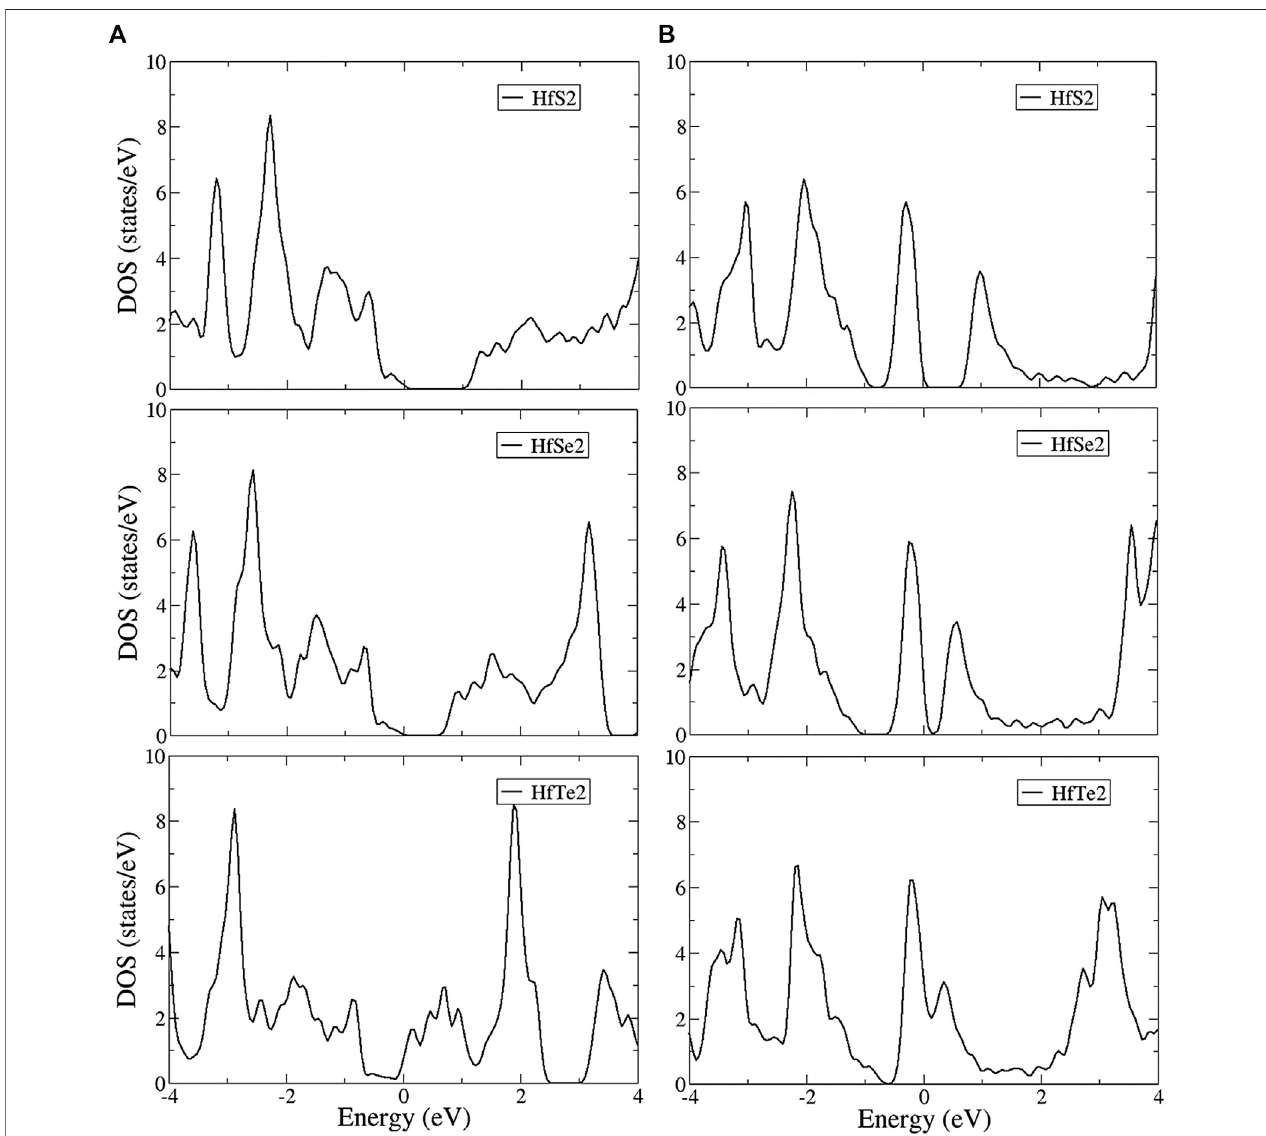
FIGURE 5 | The density of states (DOS) in the (A) T and (B) H phase of monolayer HfX 2 .